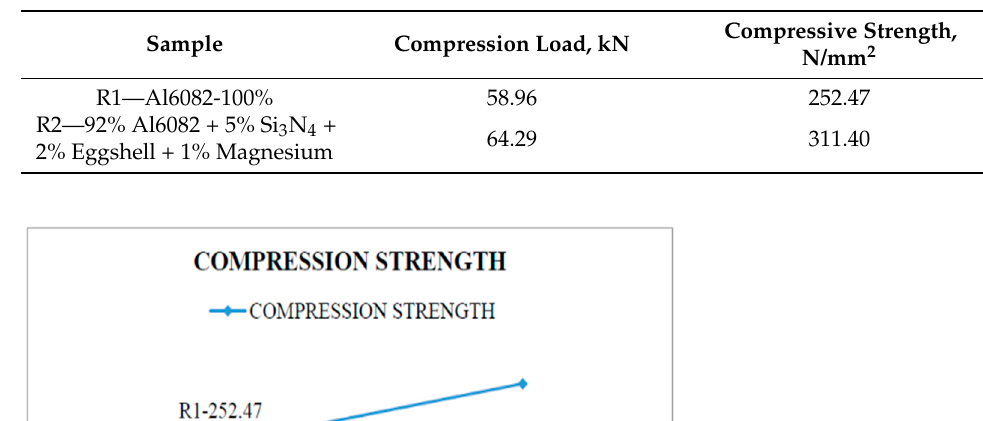
Table 6. Compression strength test value.